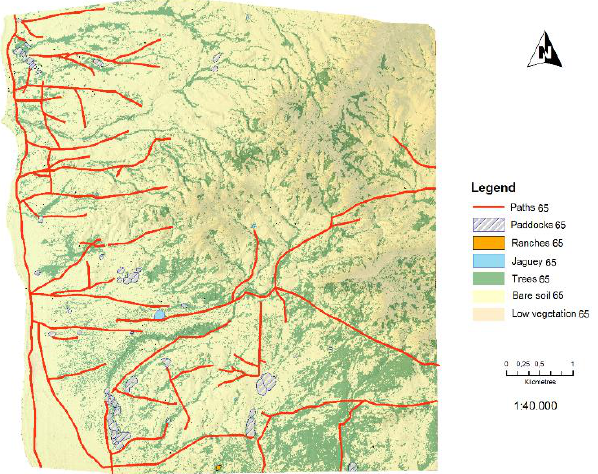
Figure 7. Land use and cover 1965.